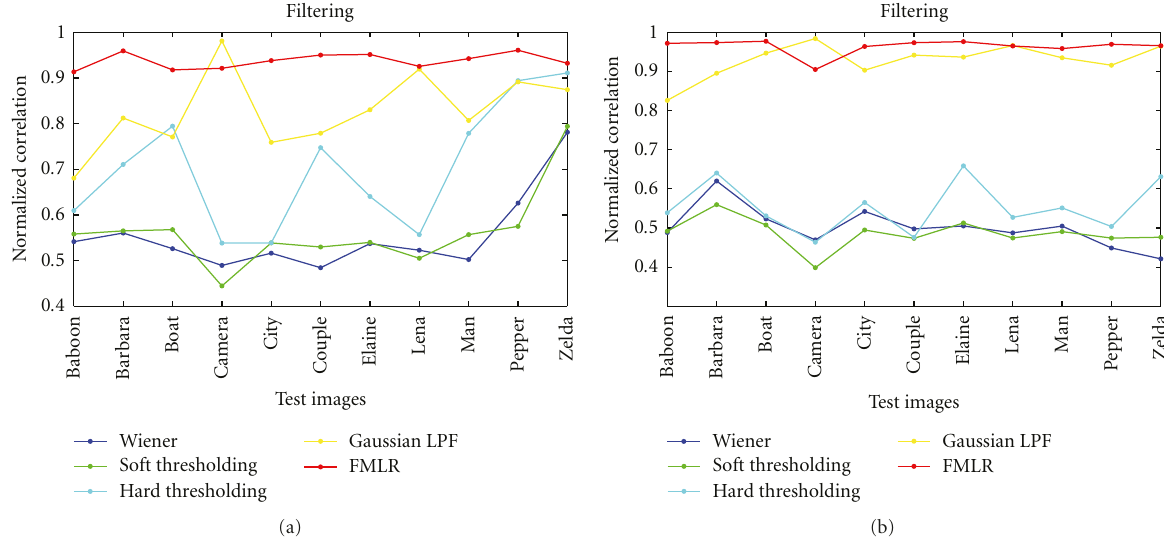
Figure 10: Normalized correlation results of di ff erent test images under di ff erent filtering attacks (window size = 3 × 3) (a) embedding the watermark in the highest frequency subband of the host image (b) embedding the watermark in the 16th directional subband.